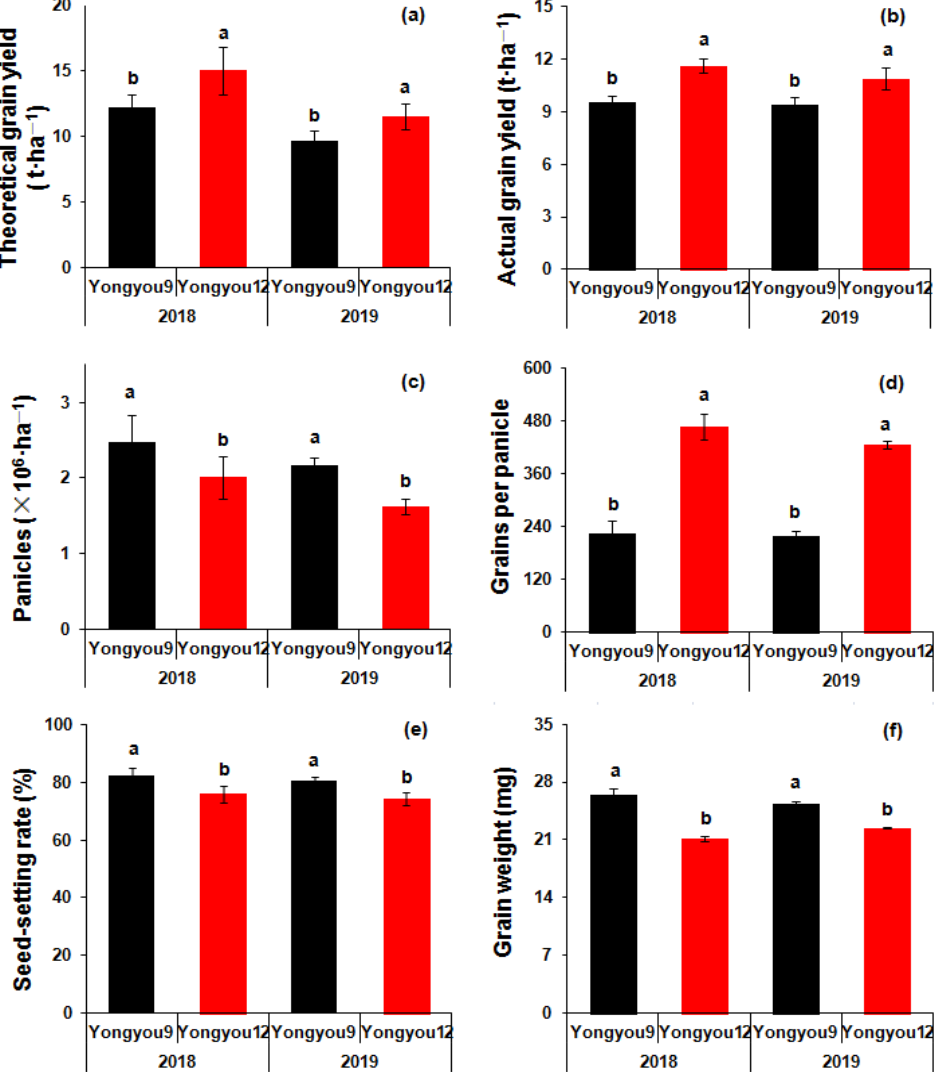
Figure 2. Rice-grain yield and its components in 2018 and 2019: ( a ) theoretical grain yield; ( b ) actual grain yield; ( c ) total panicle numbers per area; ( d ) grain numbers per panicle; ( e ) seed-setting rate; ( f ) grain weight. Error bars denote ± standard deviation ( n = 3). Different letters within the same year indicate a significant difference at the 0.05 probability level.